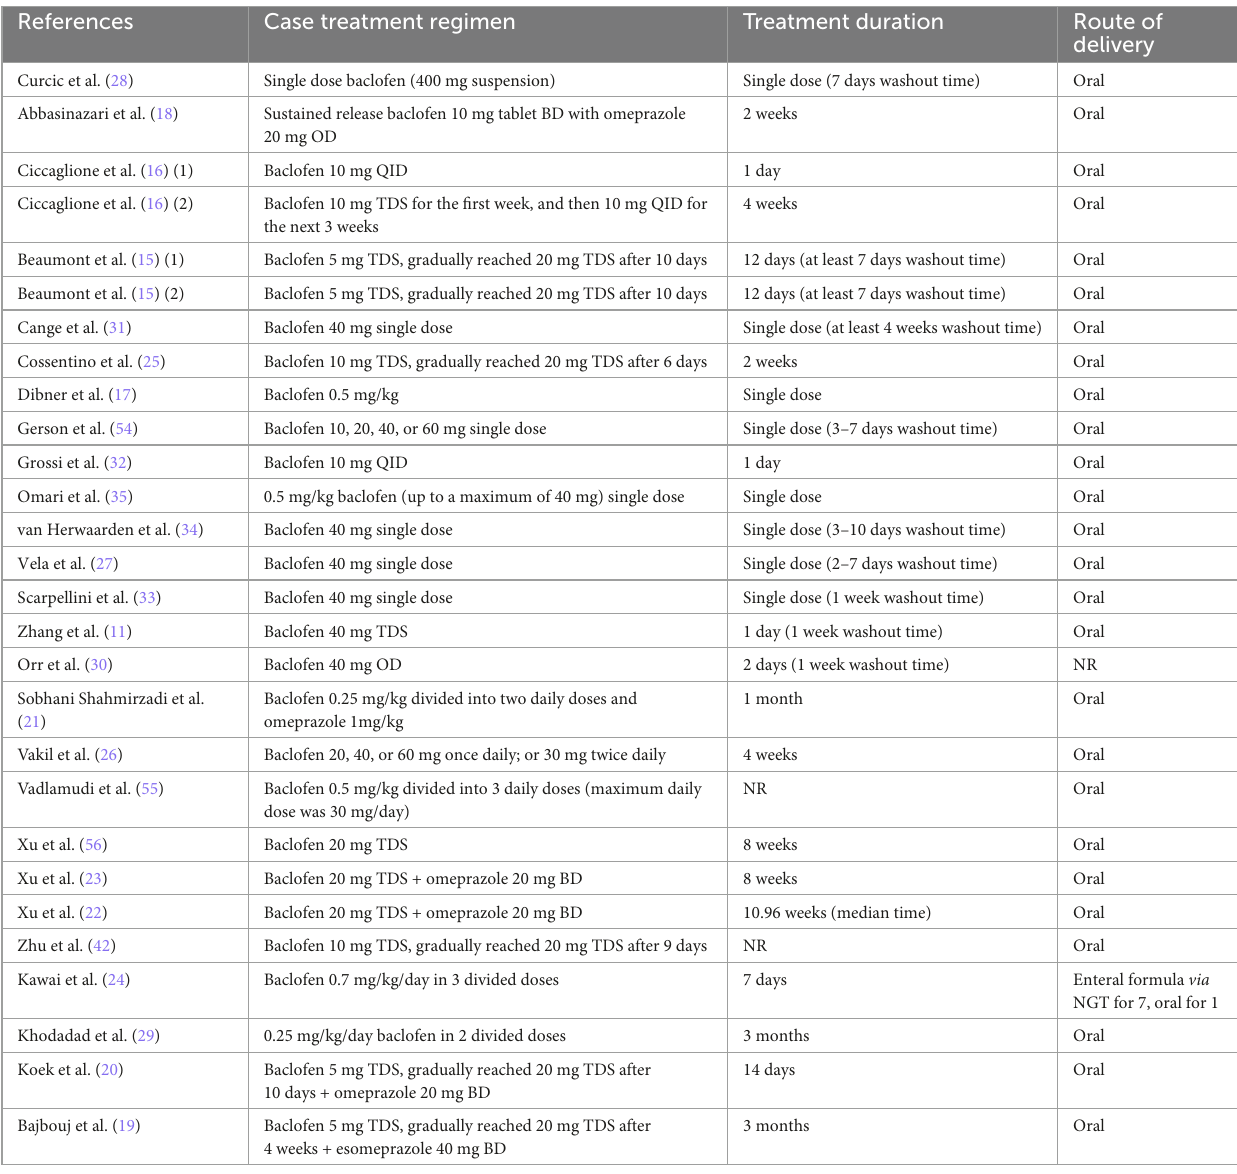
TABLE 3 Intervention